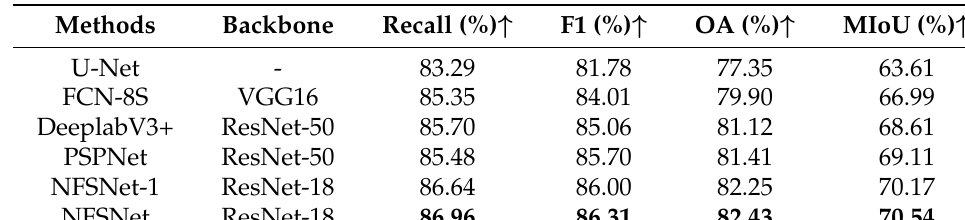
Table 1. Experimental results of Potsdam-A test set. The highest values for the different metrics are highlighted in bold, ↑ means the higher the better.